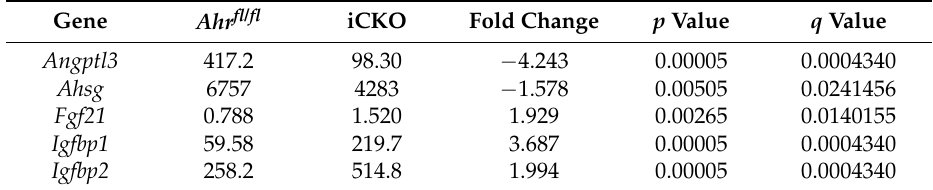
Table 1. Changes in hepatokine expression between Ahr fl/fl and iCKO mice, 1 week after tamoxifen treatment.